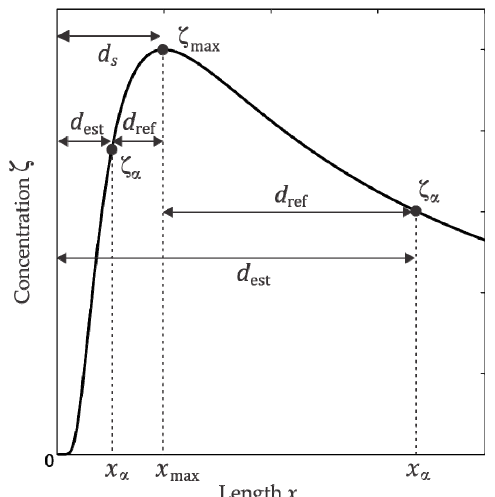
Figure 2. Determination of d ref in function of the concentration ζ α on the left or on the right in relation to ζ max . The position x = 0 corresponds to the gas source location (unknown), while the maximum concentration is found at x = x max The distance (cid:1856) (cid:2928)(cid:2915)(cid:2916) in Figure 2 is easy to measure since it represents the segment between the maximum concentration point (cid:1876) (cid:2923)(cid:2911)(cid:2934) and the point (cid:1876) (cid:2961) on the (cid:1876) ‐ axis. Depending if (cid:1856) (cid:2928)(cid:2915)(cid:2916) is to the left or right respect to (cid:1876) (cid:2923)(cid:2911)(cid:2934) , the cases 0 (cid:3407) (cid:1876) (cid:2961) (cid:3407) (cid:1876) (cid:2923)(cid:2911)(cid:2934) and (cid:1876) (cid:2961) (cid:3408) (cid:1876) (cid:2923)(cid:2911)(cid:2934) are distinguished, as Figure 2 shows. Therefore, the distance to the source on (cid:1876) ‐ axis from the maximum concentration position (cid:1876) (cid:2923)(cid:2911)(cid:2934) can be defined as: